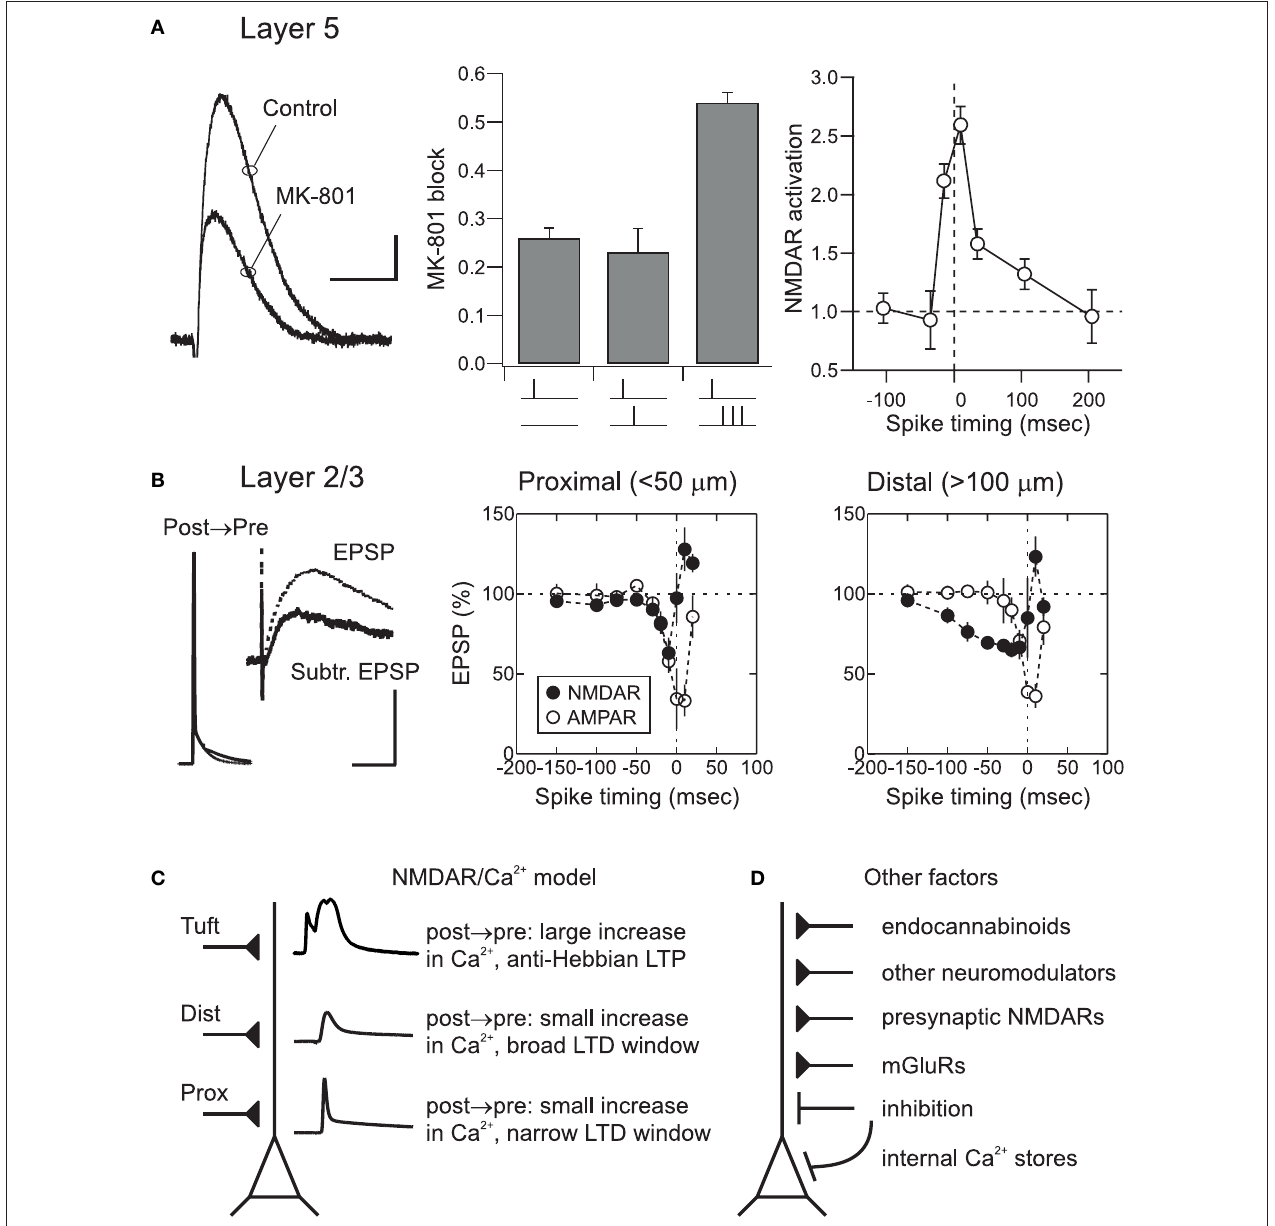
AMPA receptor mediated EPSPs seemed to be shunted by action potentials at short pairing intervals, but were otherwise unaffected by pairing (open circles). From Froemke et al. (2005). (C) The NMDAR/Ca 2 + model of STDP. In this model, Ca 2 + influx through postsynaptic NMDARs determines the degree of long-term levels of Ca 2 + influx lead to LTD, whereas higher levels induce LTP. Conventional STDP is observed at proximal synapses. At more distal dendritic